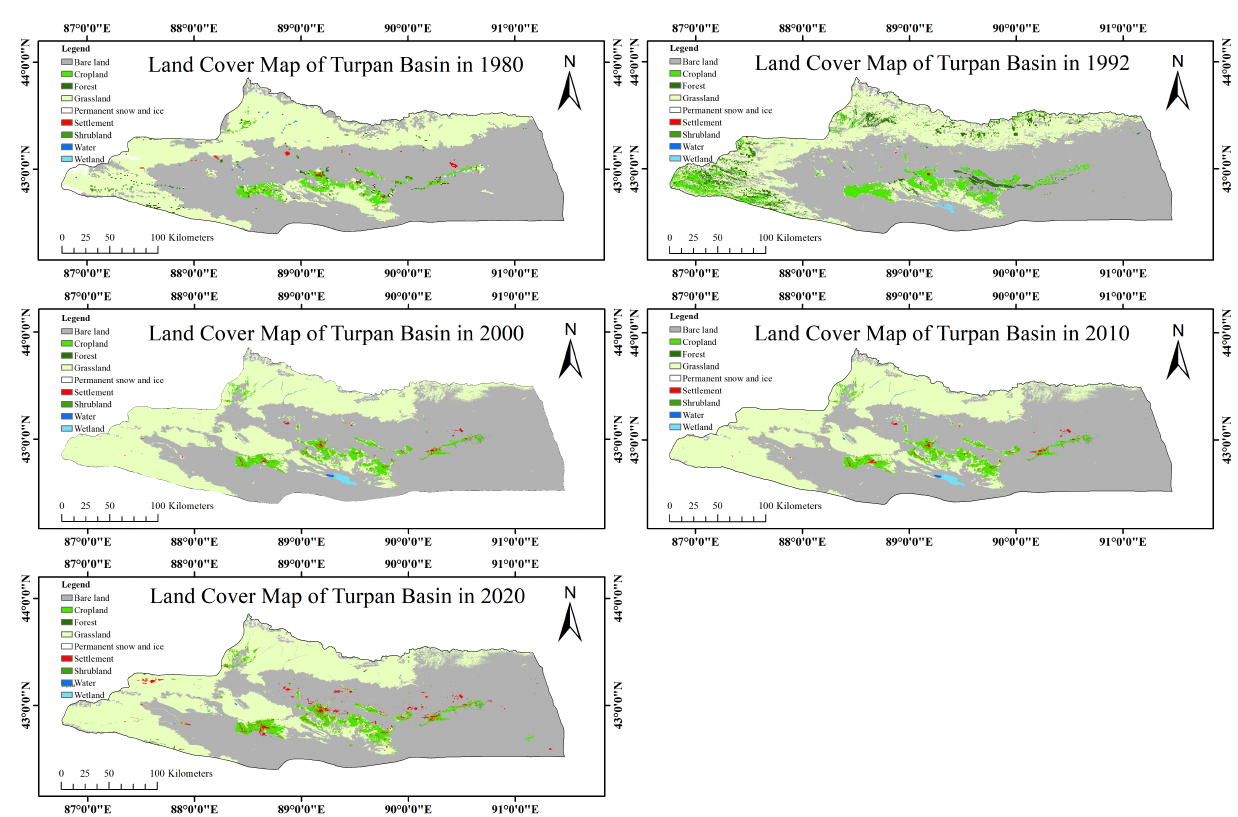
Figure 8. Land use/land cover distribution of the Turpan Basin at 10-year intervals from 1980 to 2020.